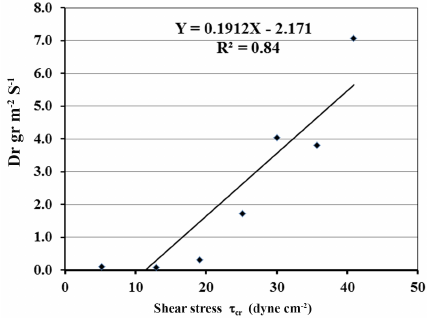
Figure 4. Relationship between shear stress ( τ ) and detachment rate in the rangeland ( P < 0.01) Figure 5. Relationship between shear stress ( τ ) and detachment rate in dry farming land ( P < 0.05).